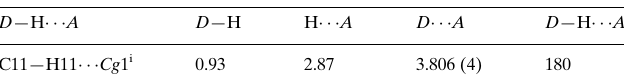
Hydrogen-bond geometry (A˚ , (cid:2)